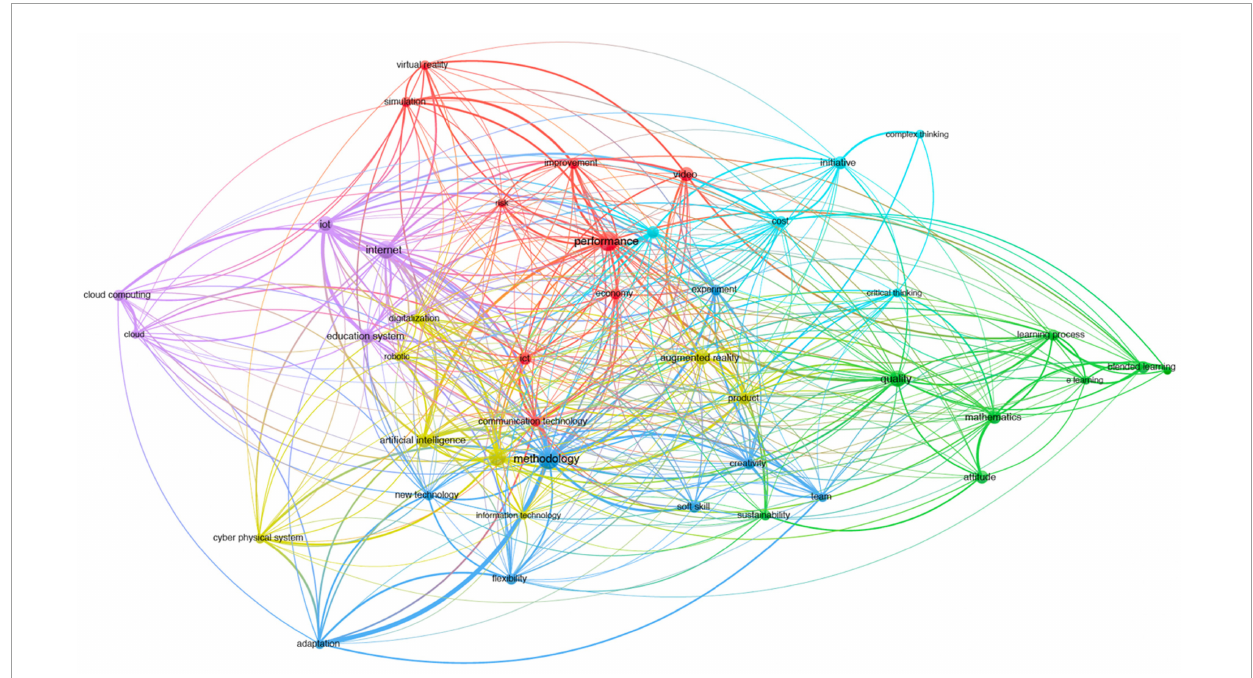
FIGURE3 The network map obtained as a response to RQ2, identifying the core components of E.D. 4.0.